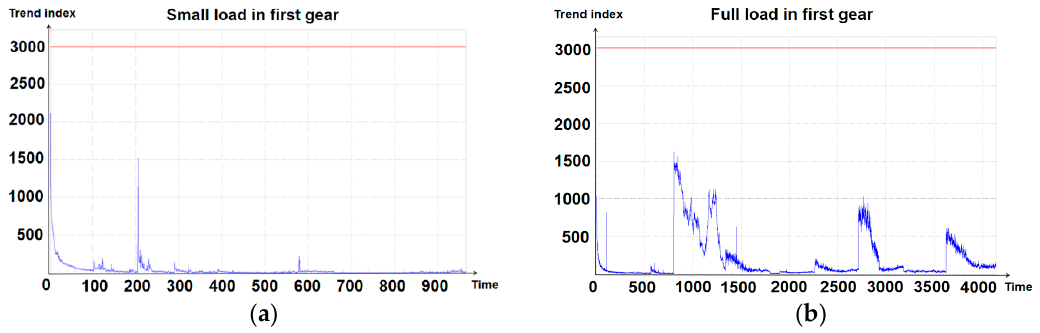
Figure 7. Small load ( a ) and full load ( b ) in first gear.